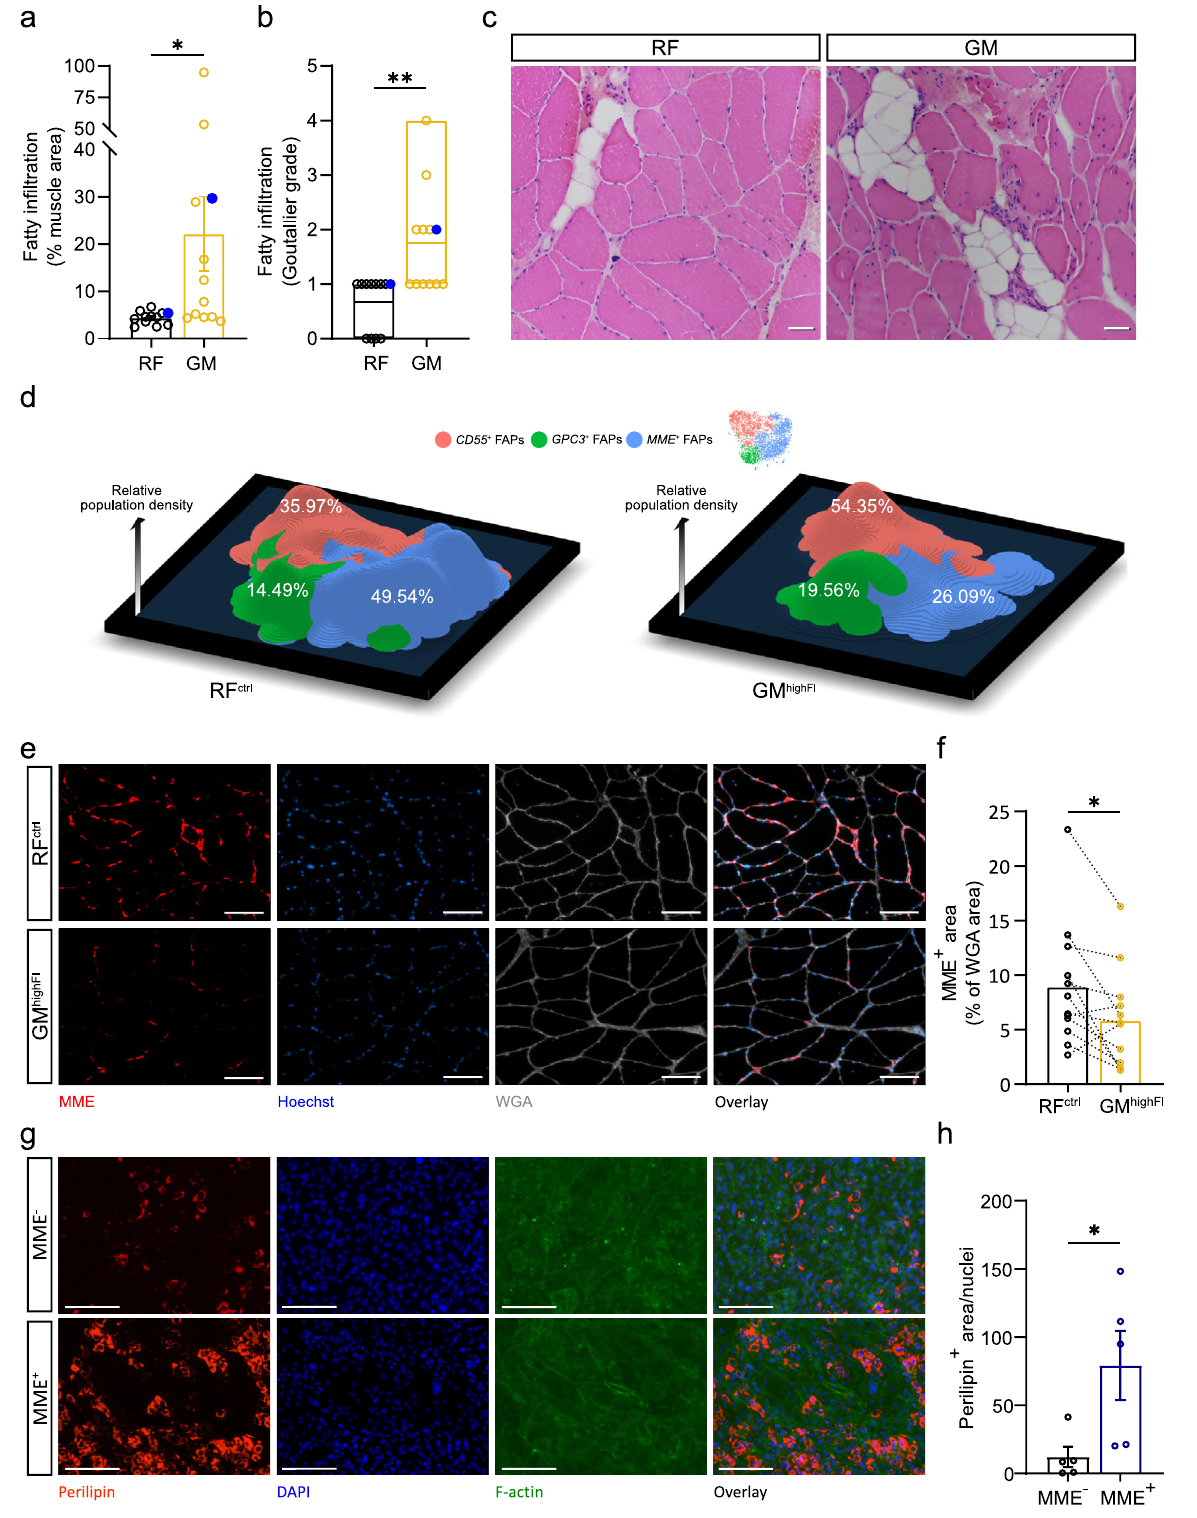
appreciable levels of non-phosphorylated β -catenin, remained highly sensitive to the adipogenic effect of insulin even after the pharmacological inhibition of GSK3 β . This lack of sensitivity to the anti-adipogenic effects of canonical WNT activation through inhibition of GSK3 β was independent of their ability to tran- scriptionally respond through the upregulation of downstream